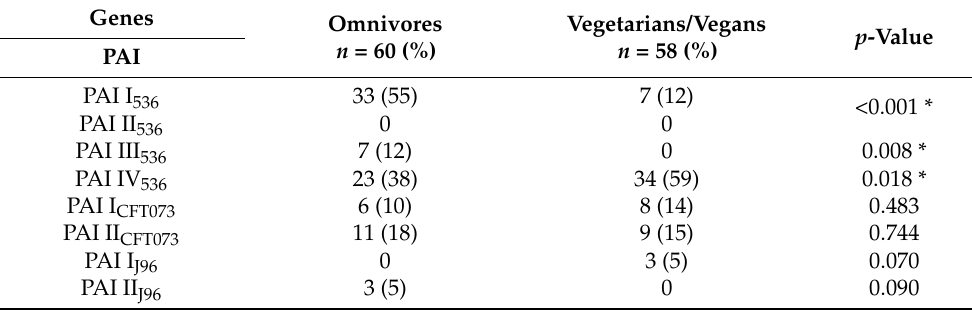
Table 7. Prevalence of PAIs among E. coli isolated from omnivores and